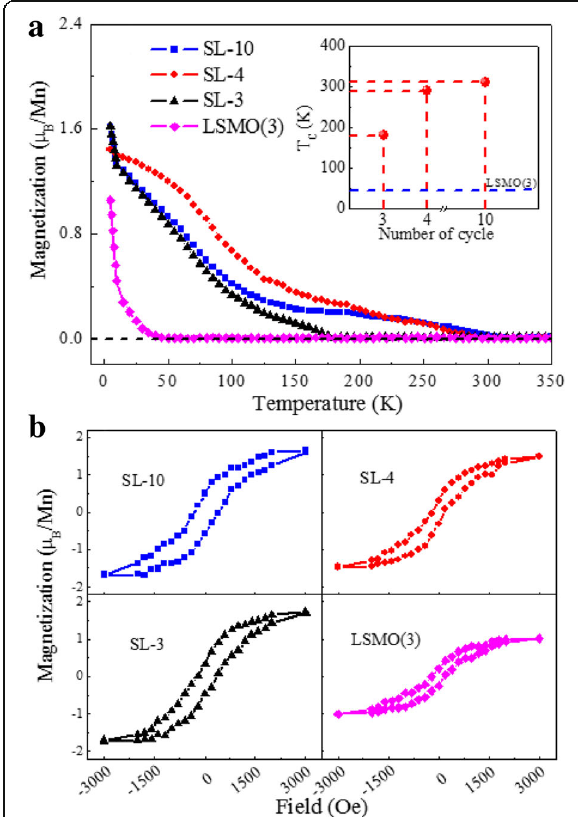
Fig. 3 a Temperature-dependent magnetization of different SL-n samples ( n = 3, 4, 10) and an ultrathin LSMO film with a 3-u.c. thickness. The magnetic field of 3000 Oe was applied in-plane along the SrTiO 3 substrates. The inset shows cycle number dependence on the T C . b The corresponding magnetic hysteresis loops of four samples measured at 5